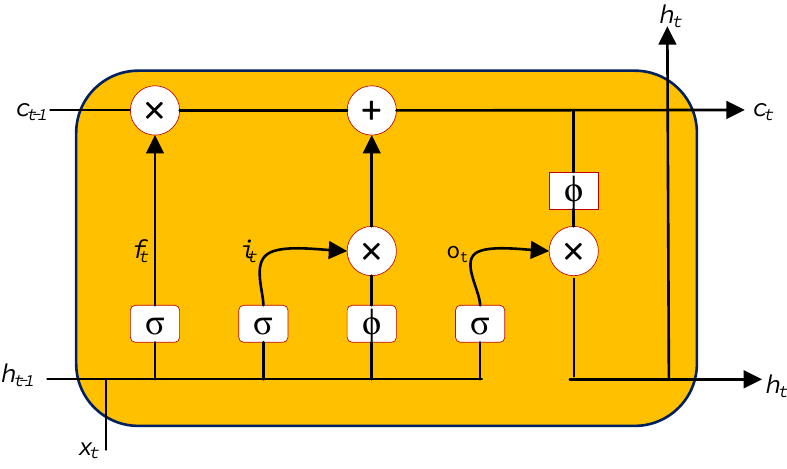
Figure 8. LSTM neural network structure.